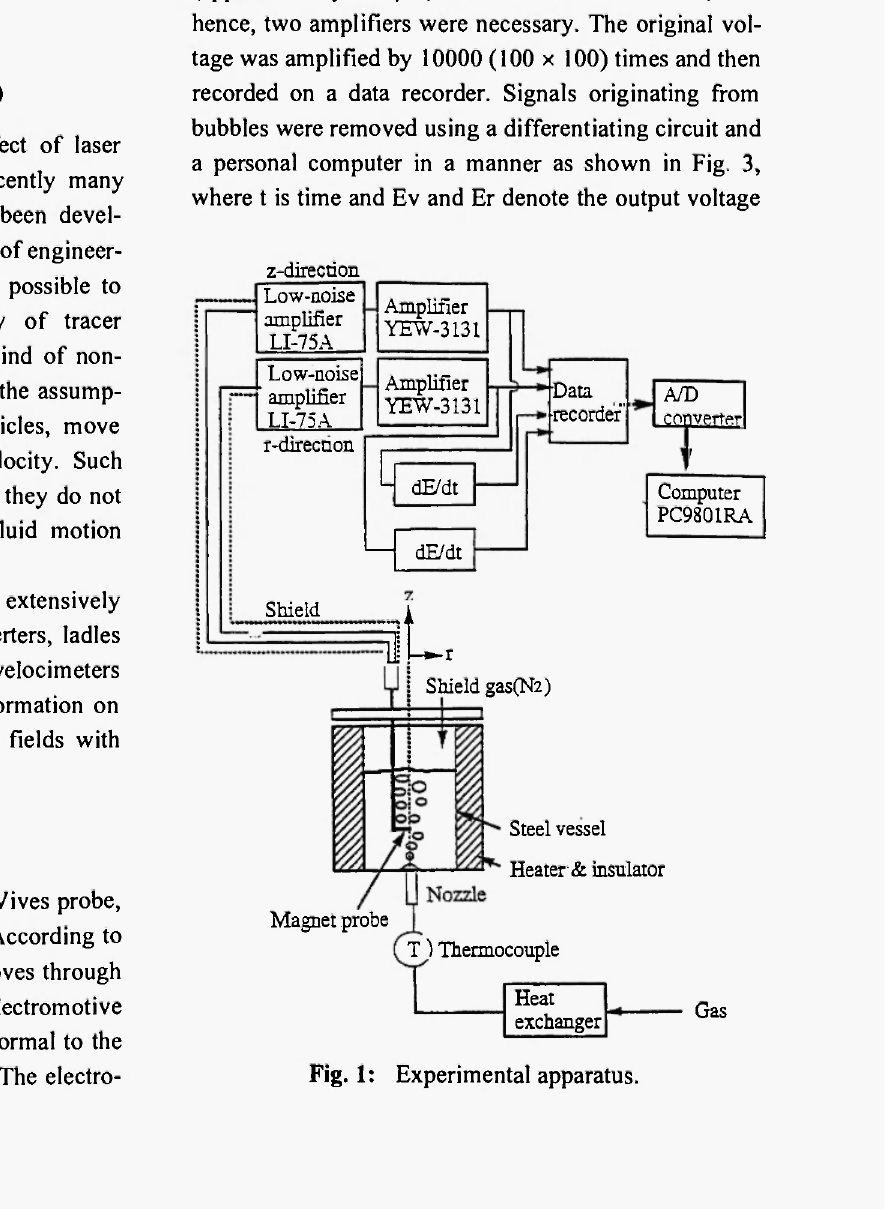
Fig. 1: Experimental